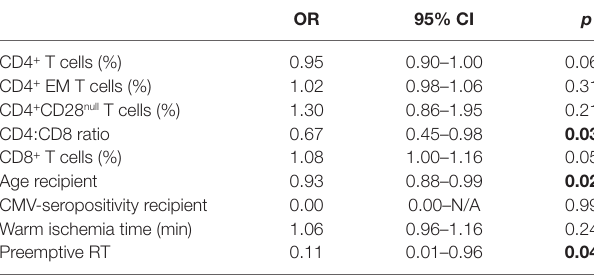
TaBle 3 | Univariate regression analysis between rejection and immunological and clinical parameters.